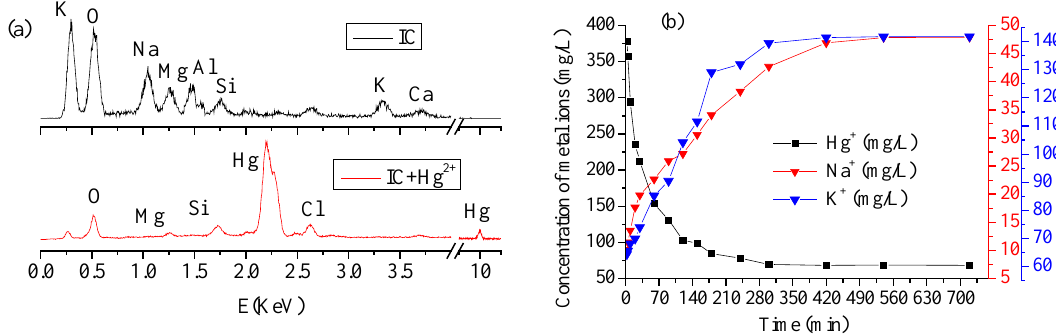
Figure 3. ( a ) EDS analysis before and after adsorption of Hg 2 + by IC; ( b ) The concentration change of K + , Na + , and Hg 2 + with oscillation time after adsorption of Hg 2 + by IC.